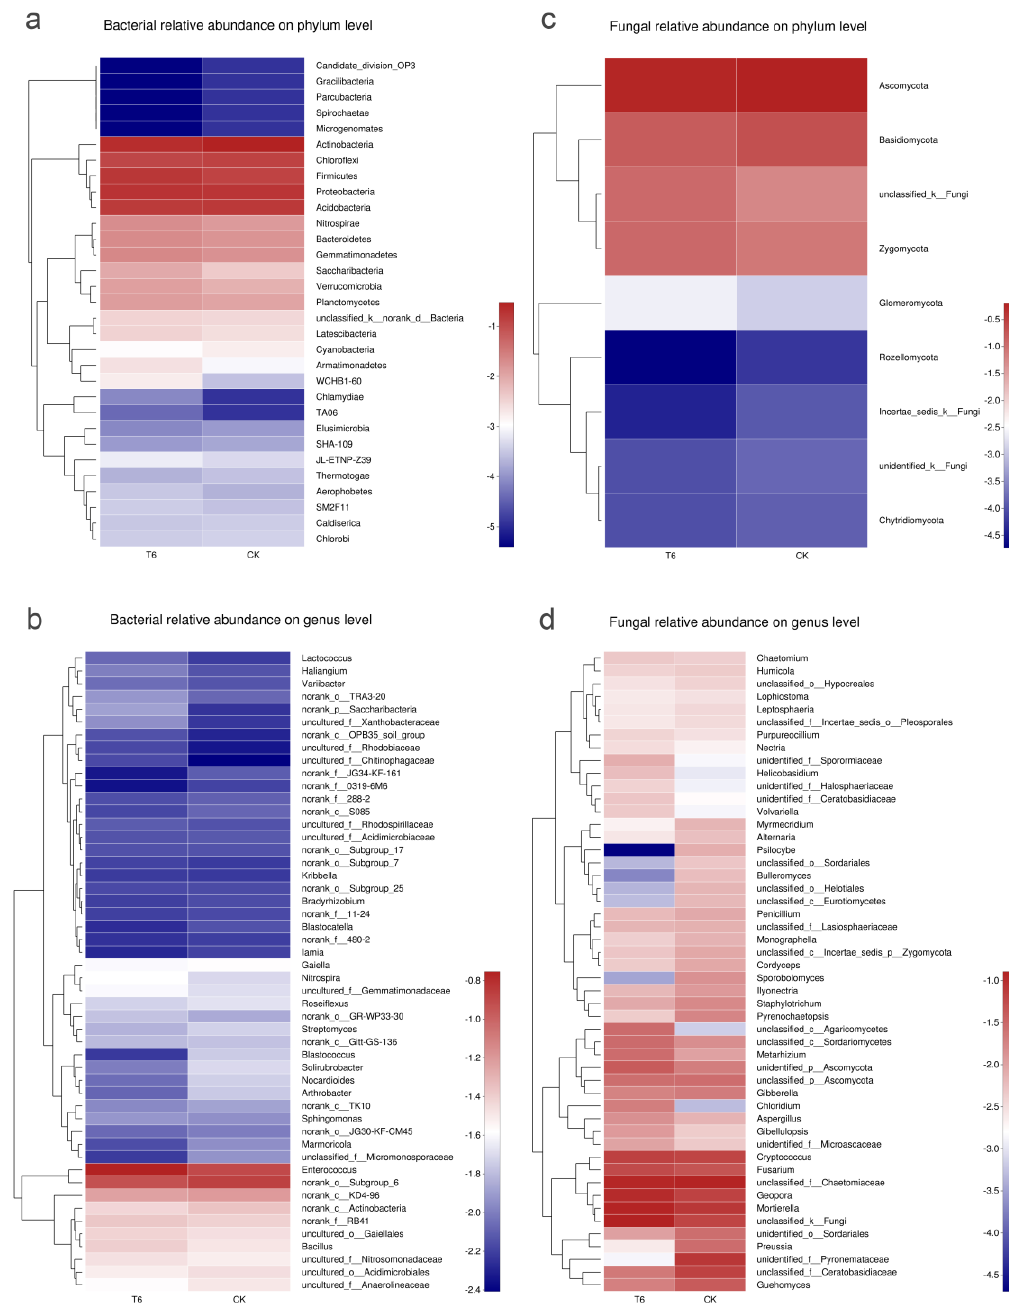
Figure 4. Bacterial and fungal distribution hierarchical clustering heatmaps ( a ) Phylum level bacterial relative abundance ( b ) Genus level bacterial relative abundance ( c ) Phylum level fungal relative abundance. ( d ) Genus level fungal relative abundance. The heatmaps illustrating distribution of diverse communities from the two groups at the genus level. The T6-1 group consisted of poplar trees, which were exposed to bacterial zymotic fluid containing T6-1. The CK group consisted of poplar trees, which were exposed to an equivalent volume of sterile zymotic fluid. We analyzed three replicates for every treatment.